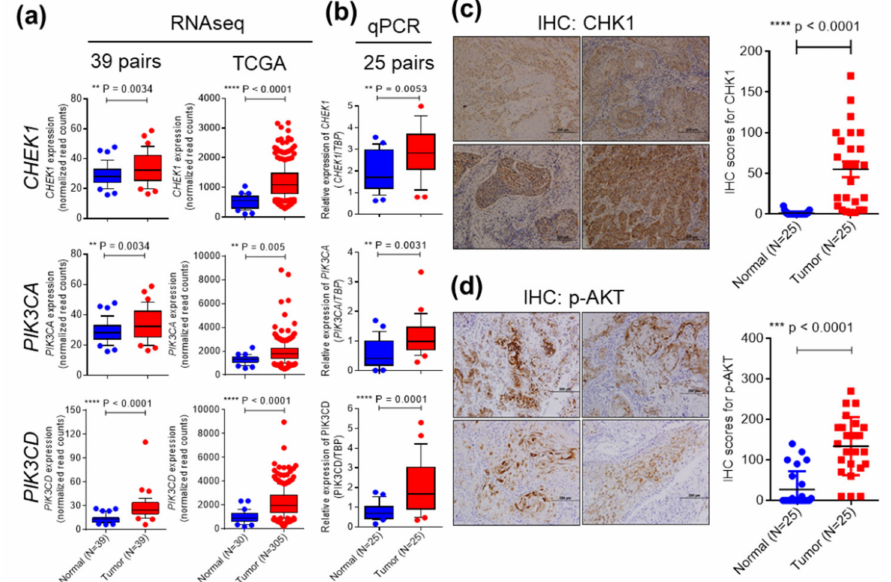
Figure 2. Expression of CHEK1 , PIK3CA , and PIK3CD is significantly upregulated in OSCC. ( a ) Tissue transcriptome datasets of the dysregulated genes in 39 paired samples from Taiwanese OSCC patients and 305 OSCC patients from TCGA were analyzed. Upon read alignment, the gene expression levels of CHEK1 , PIK3CA , and PIK3CD were determined based on the normalized read count values. ( b ) CHEK1 , PIK3CA , and PIK3CD gene expression was analyzed by qRT-PCR in paired tumor tissues and adjacent normal tissues of 25 OSCC patients. The expression levels of the targeted genes were determined by the 2 − ∆∆ CT method, and TBP was used as the control gene. The protein levels of CHK1 ( c ) and p-AKT ( d ) in OSCC patients were assessed by IHC staining. The levels of CHK1 and p-AKT were scored by multiplying the percentage of positive cells (P) by the intensity of staining (I): IHC score = P × I. A box and whisker plot is used to visualize gene expression. The whiskers extend from the 10th percentile to the 90th